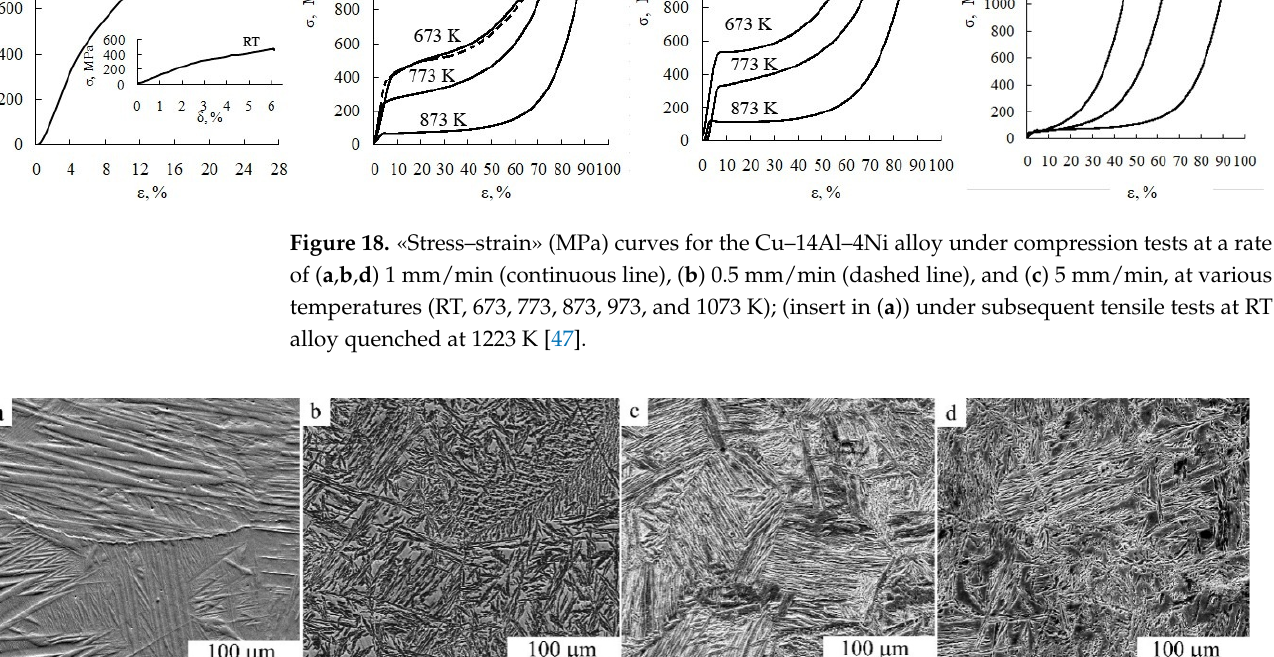
Figure 19. SEM images in SE mode of the deformation-induced martensite in the Cu-14Al-4Ni after ( a ) tensile tests or ( b – d ) compression tests at ( b ) RT and ( c , d ) 773 K (( c )— v =5 mm/min, ( a , b , d )— v =1 mm/min) [47].